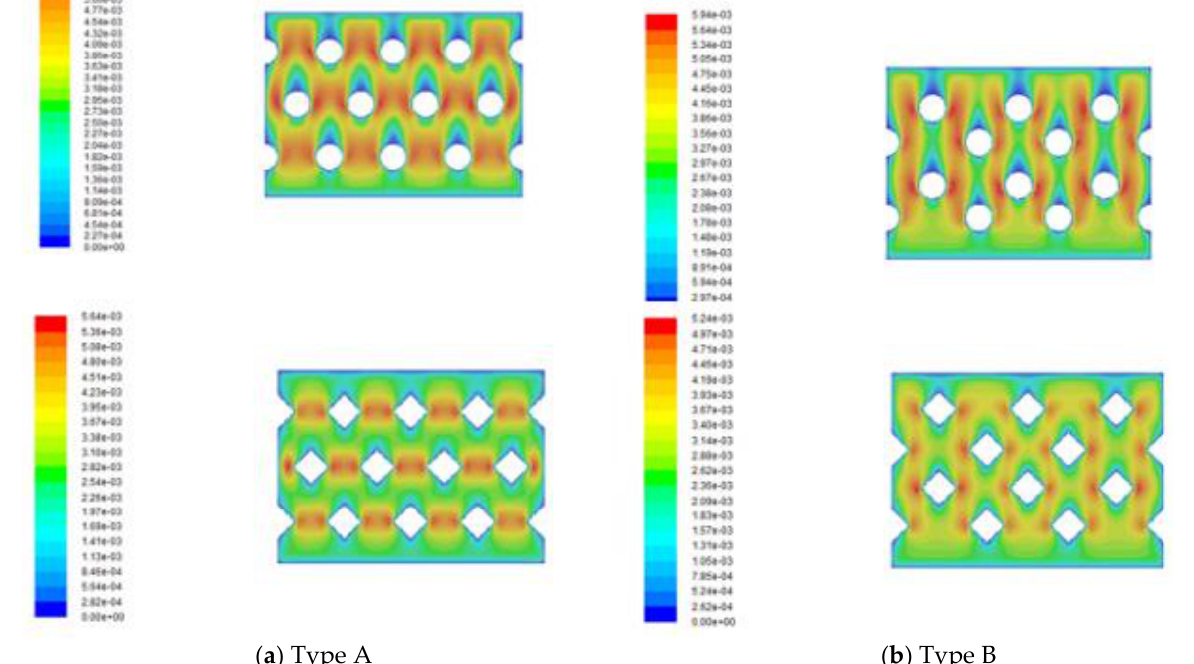
Figure 8. Simulation result of velocity profiles in different arrangements of turbulence promoters.